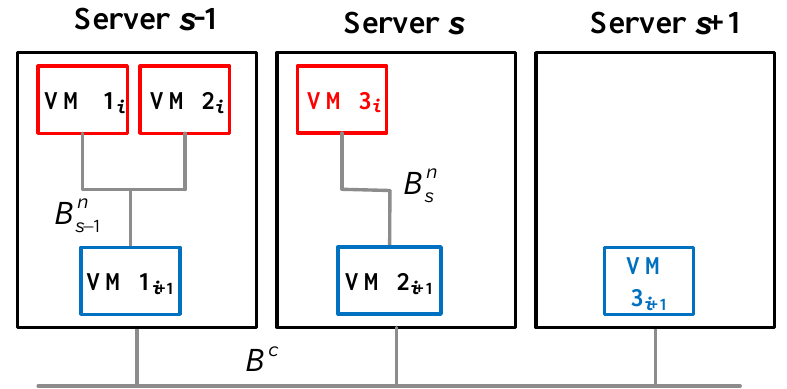
Figure 2. Representation of internal and external transmissions between VMs in